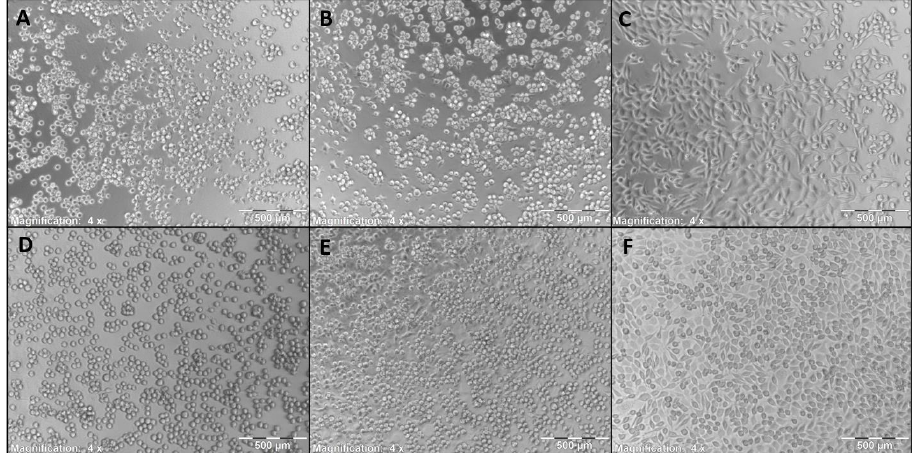
Figure 8. L-929 mouse fibroblasts grown on the coatings for 48 h. ( A ) GlcNAc-2EG-PDMAm, ( B ) GlcNAc-4EG-PDMAm, ( C ) 10%-GlcNAc-4EG-PDMAm, ( D ) GlcNAc-6EG-PDMAm, ( E ) PDMAm, ( F ) untreated cell culture dish. Morphology is altered to some extent, but cell viability is still given